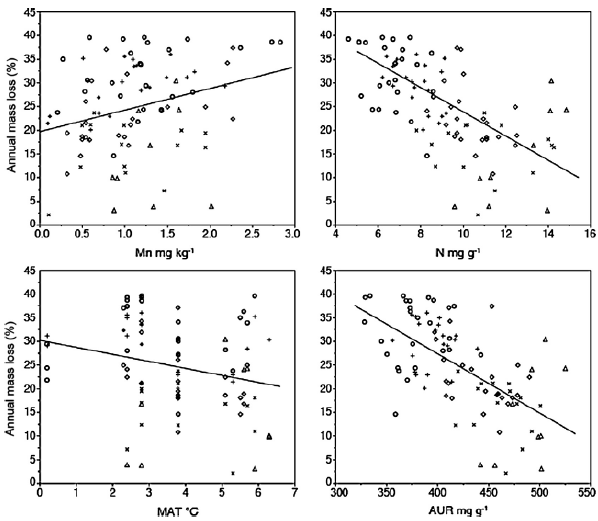
Figure 3. Linear regressions between annual mass loss (%) and concentrations of Mn (upper left. R 2 = 0.08, p = 0.0046), N (upper right. R 2 = 0.39, p < 0.0001), AUR (lower right. R 2 = 0.39, p < 0.0001) and MAT (lower left, with R 2 = 0.06, p = 0.017). Annual litter mass loss has been determined from 5